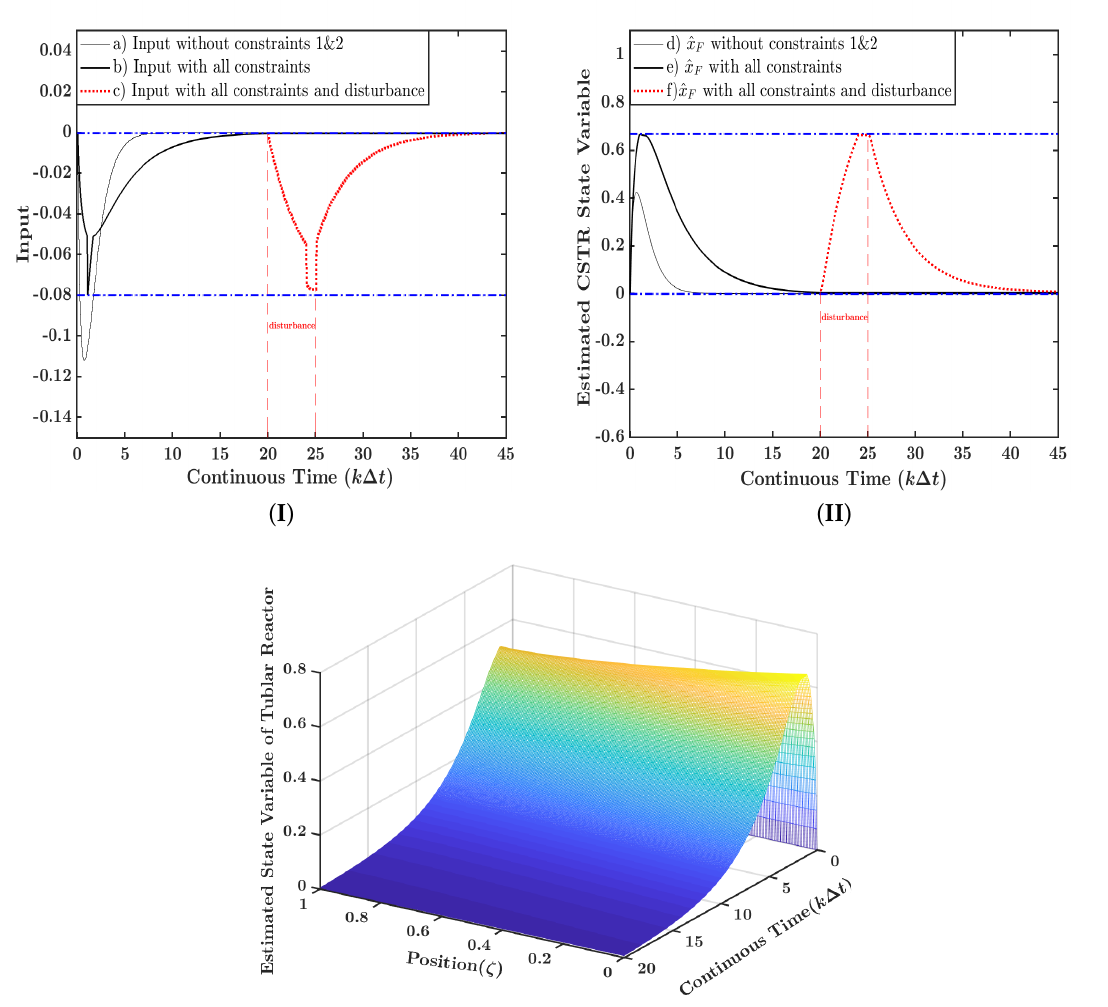
Figure 7. ( I ) (a), (b) and (c) demonstrate the comparison between input profiles under model predictive control law: with and without input/state constraints, with constraints and with disturbance for 20 ≤ t ≤ 25; ( II ) (d), (e) and (f) denote reconstructed dynamics of the scalar variable within the CSTR under model predictive law: with and without input/state constraints, with constraints and with disturbance for 20 ≤ t ≤ 25; ( III ) Evolution of the stabilized spatial profile for the tubular reactor with all